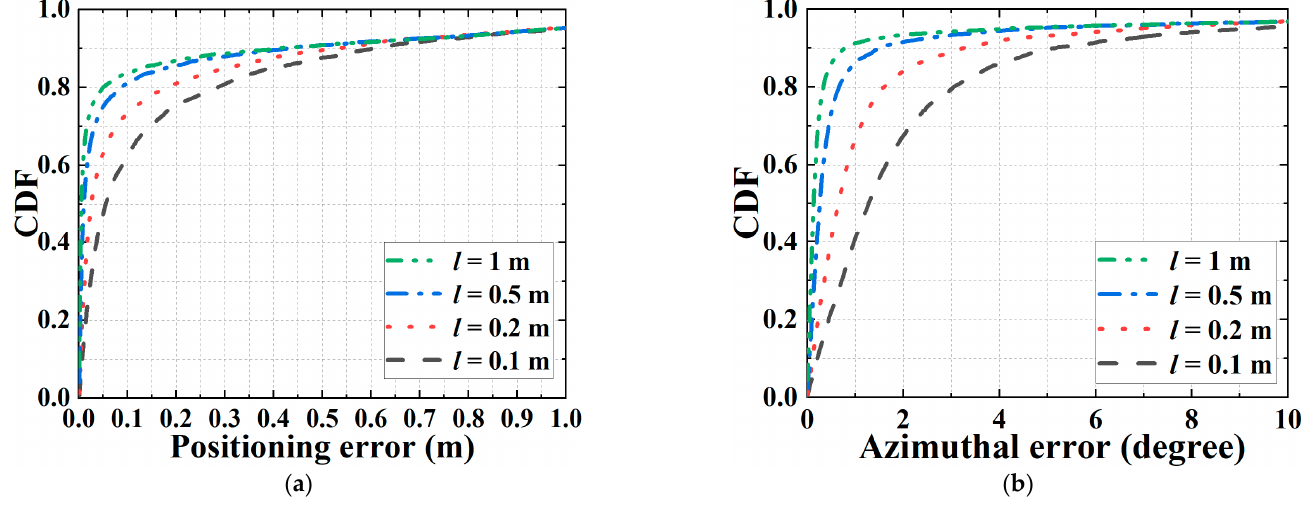
Figure 8. CDFs at (1.5, 2, 1) for: ( a ) 3D positioning errors; and ( b ) azimuthal errors. ( θ = 30°).